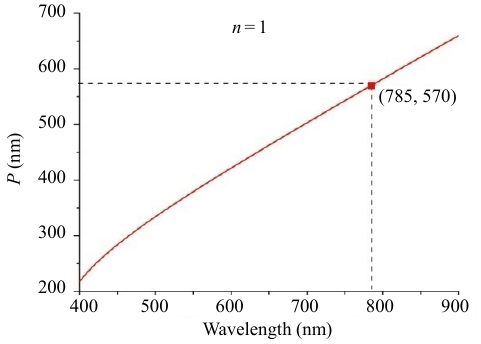
Fig. 3 Grating period vs wavelength of excitation light in SPPs